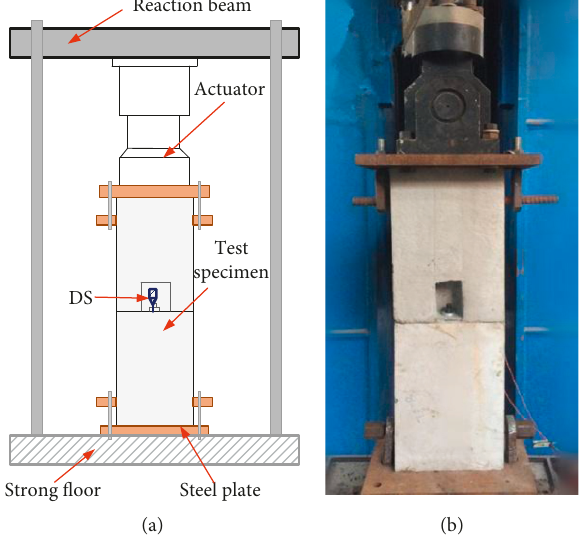
Figure 5: The axial tensile test setup: (a) test setup of the specimens and (b) test